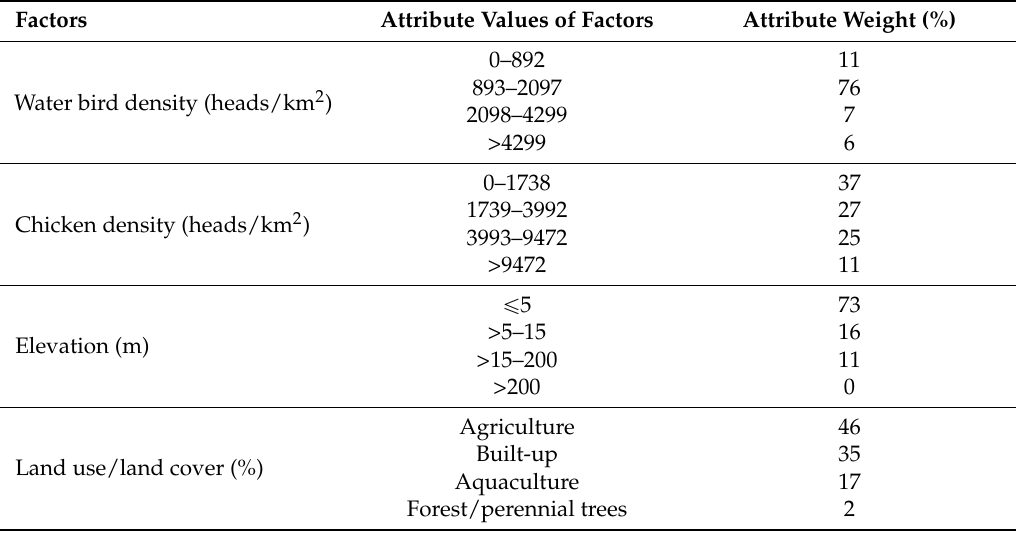
Table 3. Attribute weight of each group within a